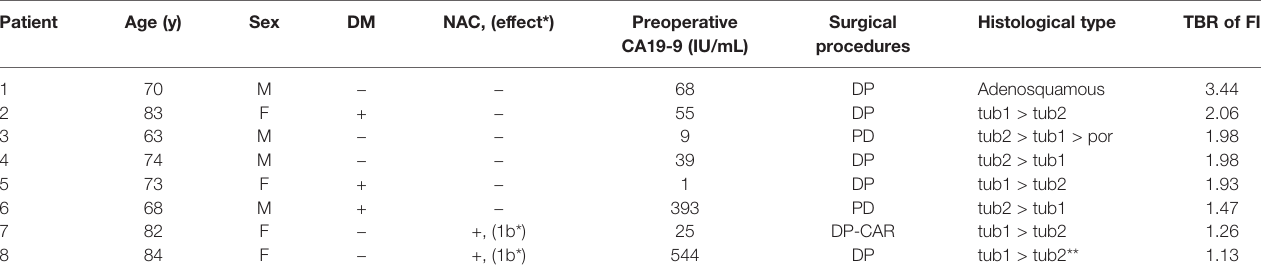
TABLE 1 | Patients ’ demographic characteristics and outcomes of fl uorescence imaging using GP-HMRG.